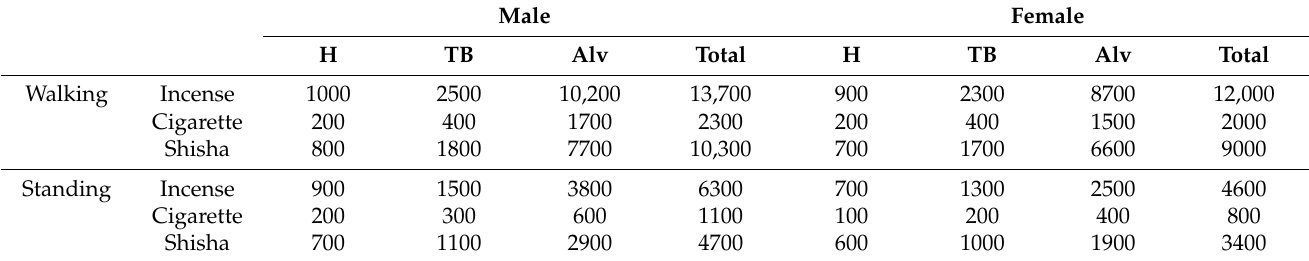
Table 2. Regional inhaled deposited dose rate ( × 10 9 #/h) calculated based on submicron particle number ( PN Sub , diameter < 1 µ m) concentration for adult males and females during two main activities (walking 4 km/h and standing). Abbreviations H, TB, and Alv are for head and throat airways, tracheobronchial, and pulmonary/alveolar regions, respectively.